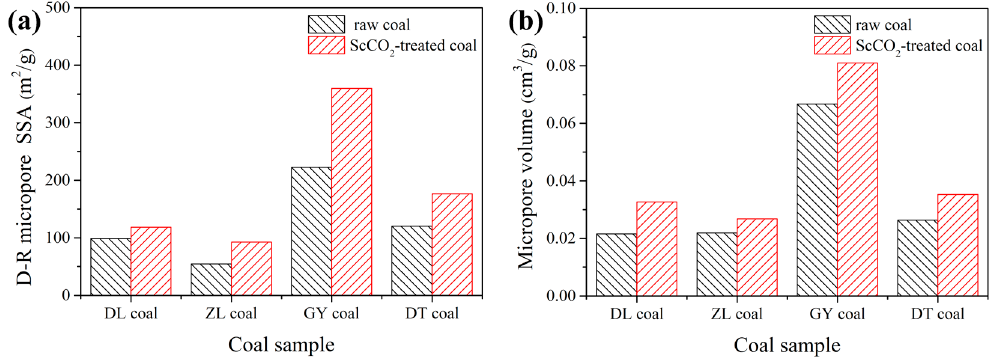
Figure 7. D-R micropore SSA and volume of the raw and ScCO 2 -treated coal samples: ( a ) micropore SSA; ( b ) micropore volume.